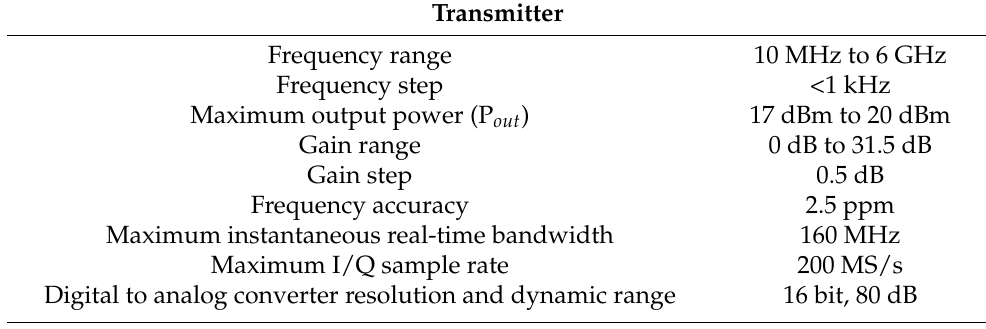
Table 2. USRP 2944R specifications [22].